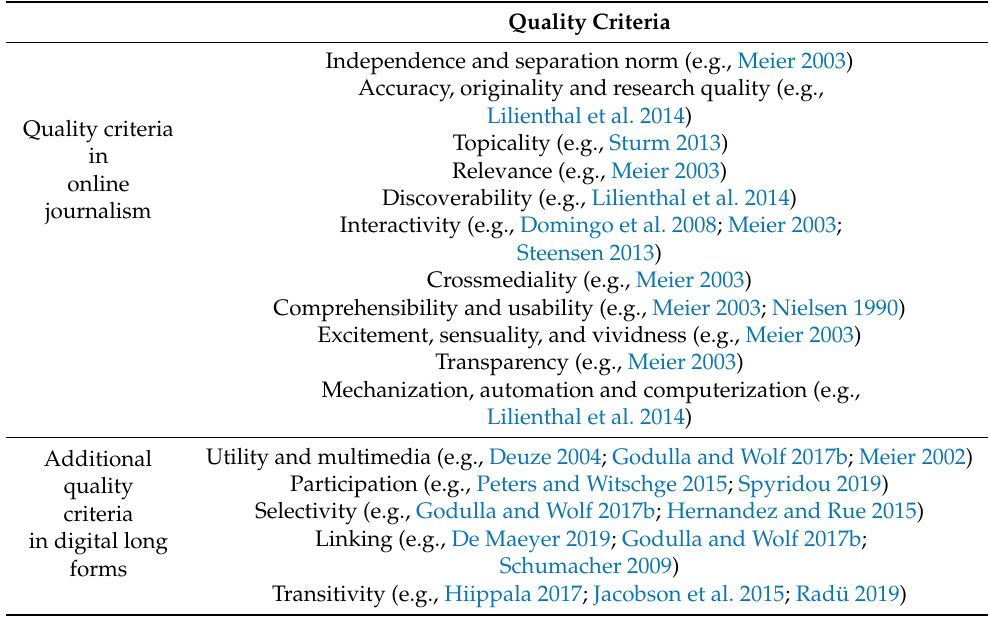
Table 1. Overview of identified quality criteria of online journalism and digital long forms. Quality